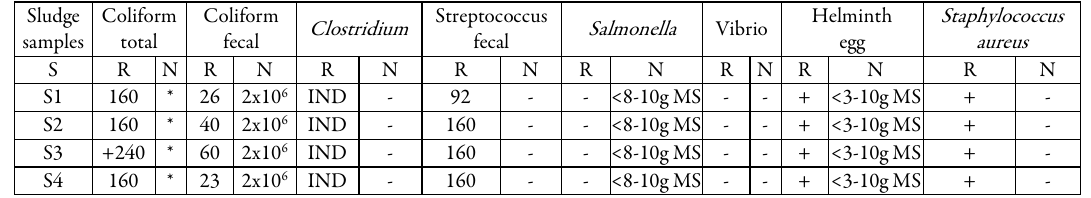
Table 3. Microbiological parameters of sewage sludge used in the